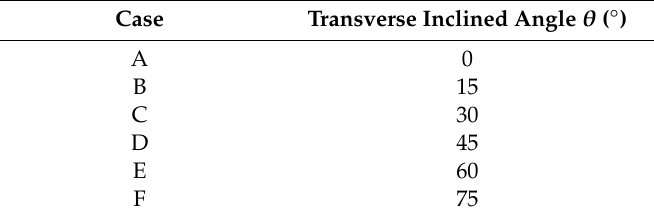
Table 1. Overview of six cases with di ff erent transverse inclined angles ( H = 1.3 m, T = 4.0 s, d = 3.8 m).